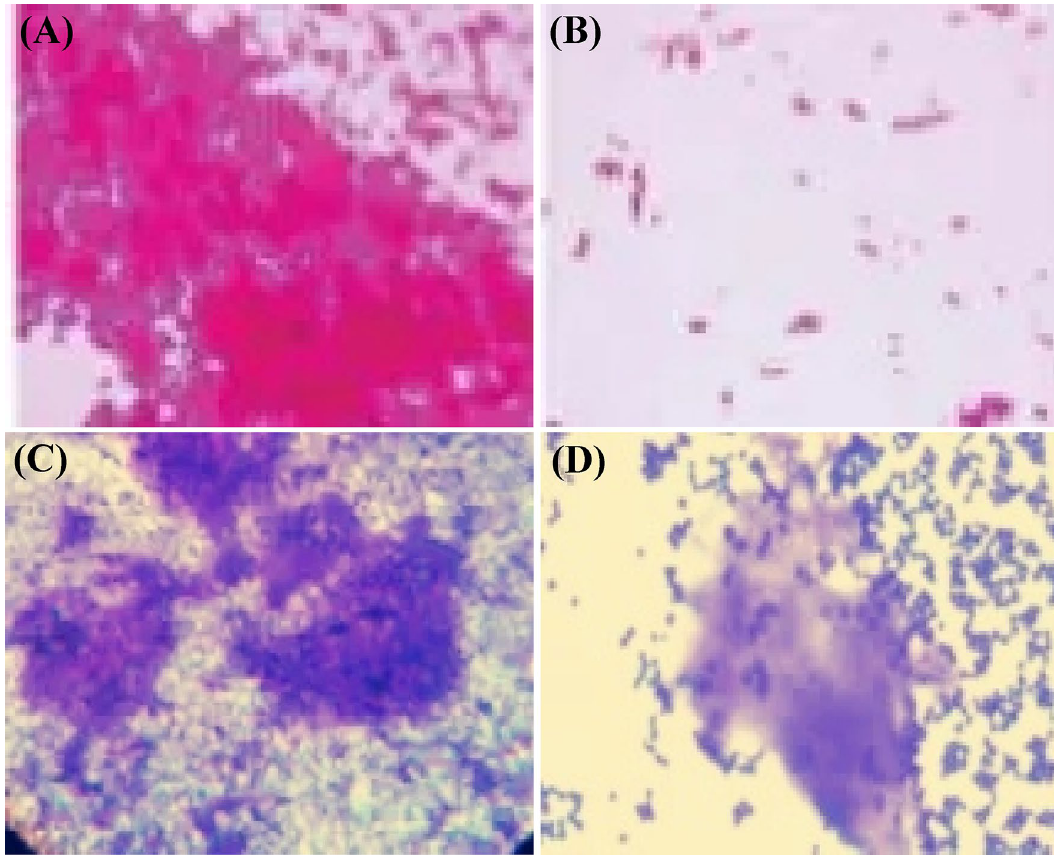
Figure 12. Microscopic examination (40×) of anti-biofilm activity of endoglucanase enzyme on ( A ) P. aeruginosa biofilm untreated ( B ) P. aeruginosa biofilm treated ( C ) S. aureus biofilm untreated ( D ) S. aureus biofilm treated.